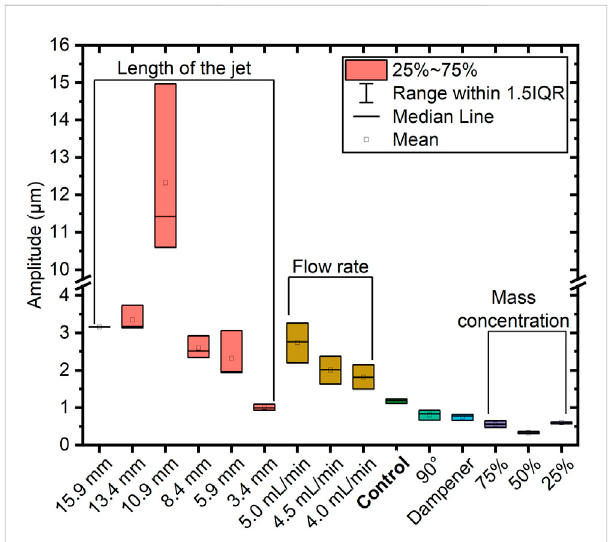
FIGURE 6 A summary of sheet generation parameters ’ in fl uences on the motion amplitude of the liquid